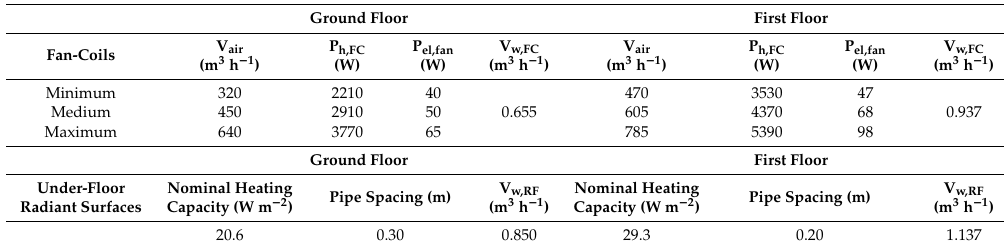
Table 2. Main technical data of